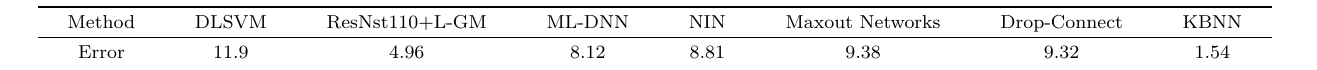
Table 3 Classification errors (%) using CIFAR-10